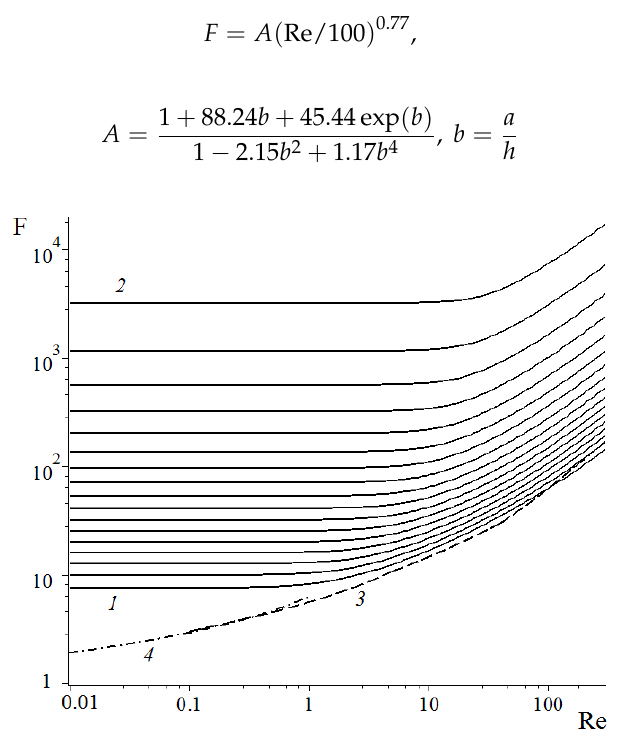
Figure 2. The dimensionless fiber drag force ( F ) in a row of fibers vs the Reynolds number for different distances between the fiber axes with a / h computed with the step 0.05 starting from a / h = 0.1 (curve 1 ) to 0.9 (curve 2 ); curve 3 is determined by the regression formula for an isolated fiber, Equation 7 [32]; and curve 4 is determined by the Lamb formula for an isolated fiber [33].